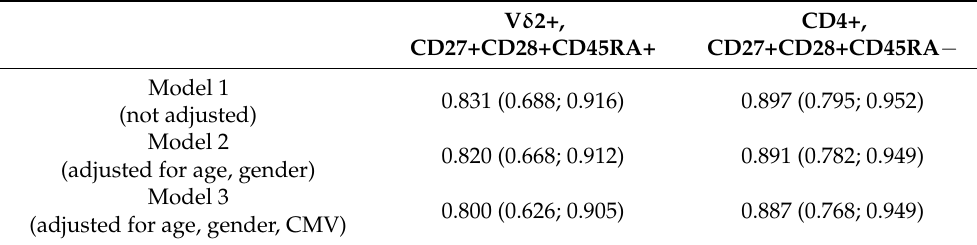
Table 3. Broad sense heritability and 95% CI using the best fitting model (AE